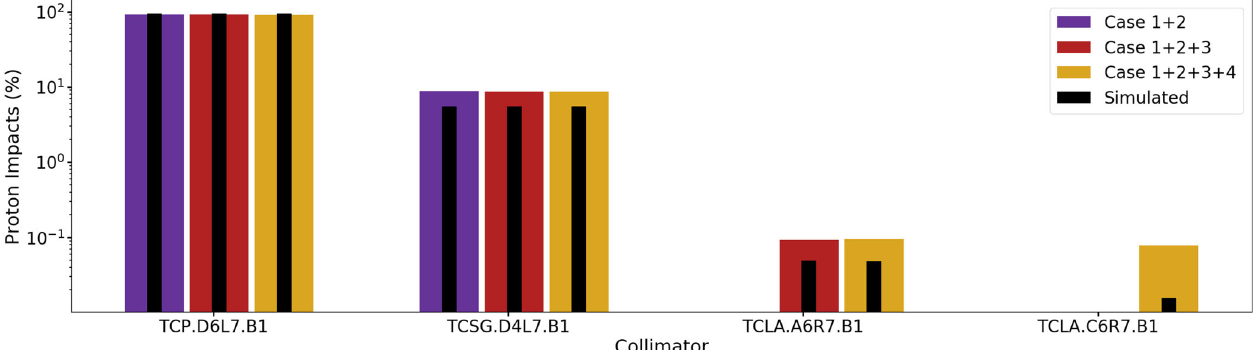
FIG. 14. A comparison of the percentage distribution of the predicted and simulated proton impacts for the three configurations in the vertical plane in beam 1: case B1V- 1 þ 2 , case B1V- 1 þ 2 þ 3 , and case B1V- 1 þ 2 þ 3 þ 4